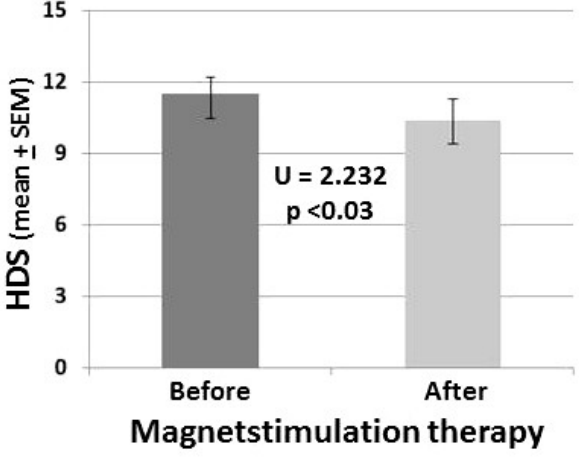
Figure 1: HAMD-7 depression scale before and after 10 sessions of rTMS treatment (Mean values ± SD are